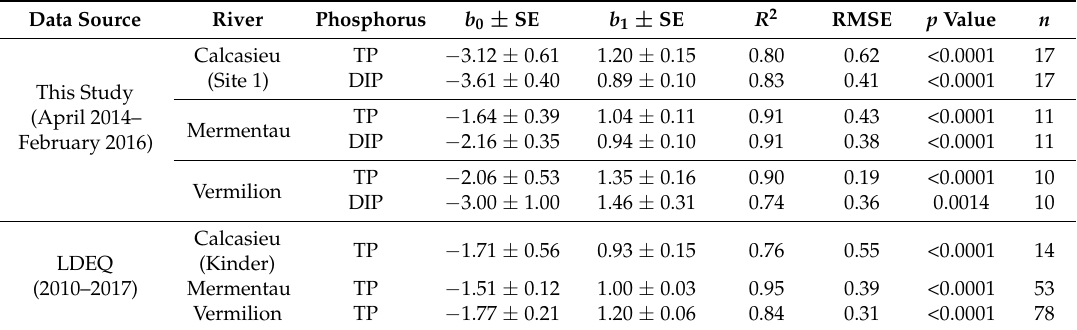
Table 1. Parameter estimates ( b 0 and b 1 ) used in Equation (1) for estimating total phosphorus (TP) and dissolved inorganic phosphorus (DIP) fluxes and their regression coefficients ( R 2 ) for the Calcasieu, Mermentau, and Vermilion Rivers using data from this study and Louisiana Department